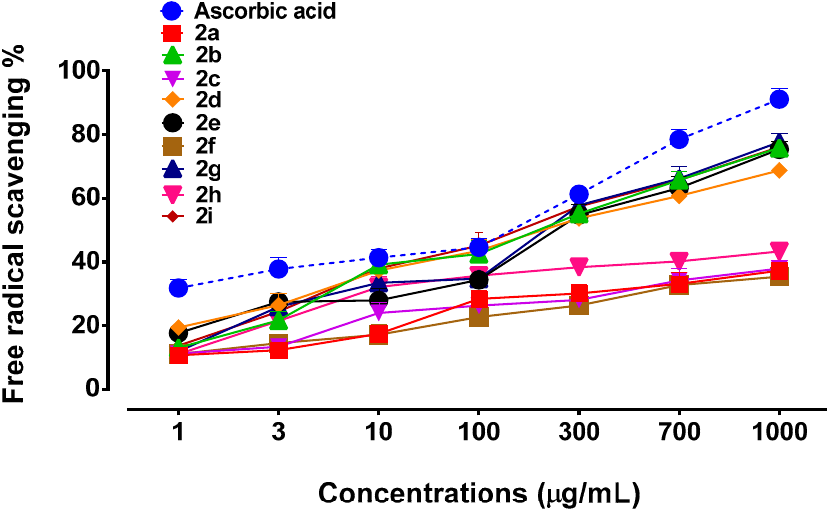
Figure 3. Illustrates percent free radical scavenging of novel succinamide derivatives ( 2a–2i ) and ascorbic acid against 2,2-diphenyl-1-picrylhydrazyl (DPPH) free radical. Values are expressed as mean ± SEM.